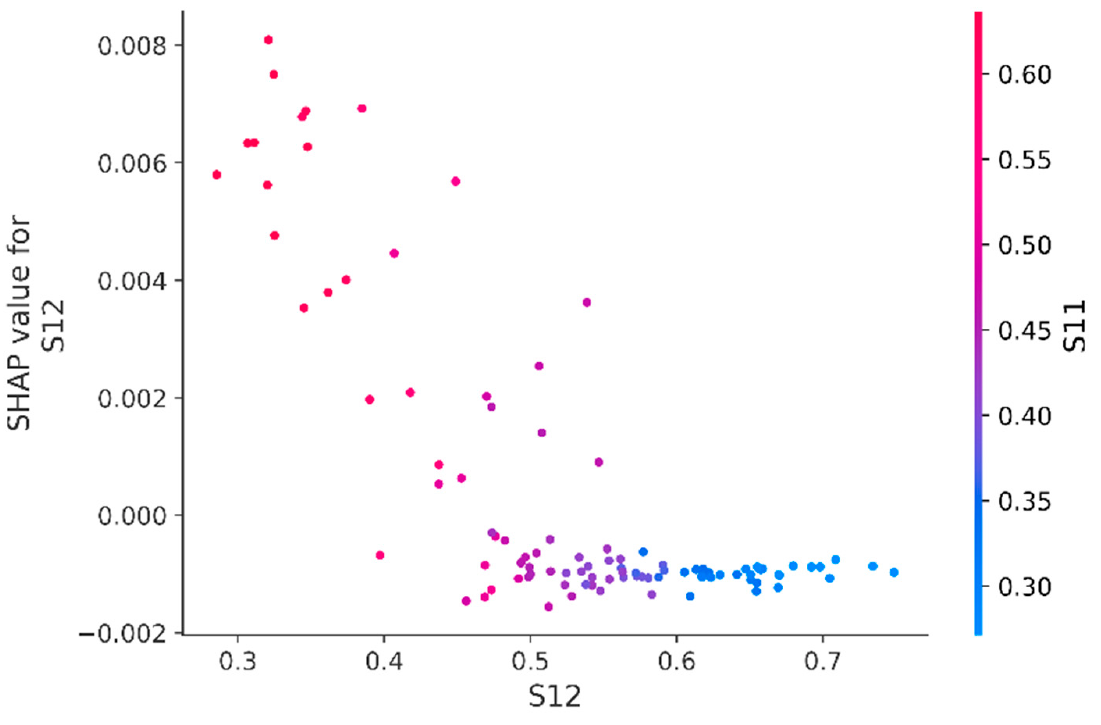
Figure 15. The dependence of the SHAP values of the S12 feature averaged over time windows on its value (the gradient indicates the value of the S11 feature).